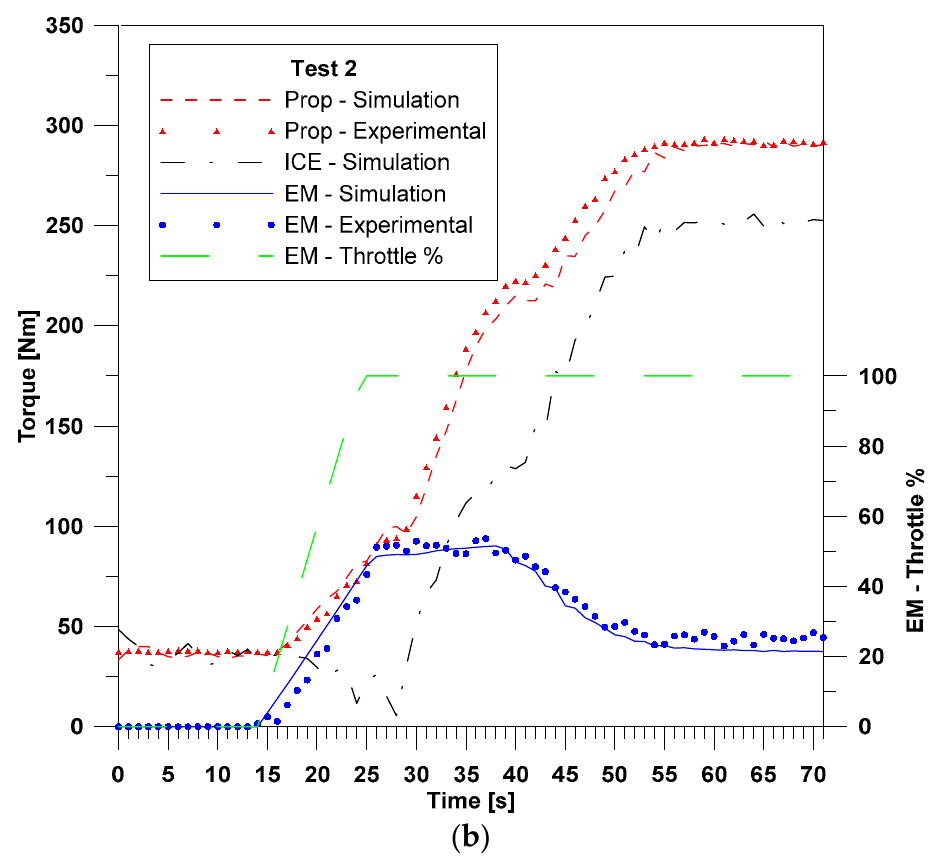
Figure 9. Test 2: ( a ) experimental and calculated speed curves; ( b ) experimental and calculated torque curves. Table 6. Test 2 simulation error and error standard deviation.